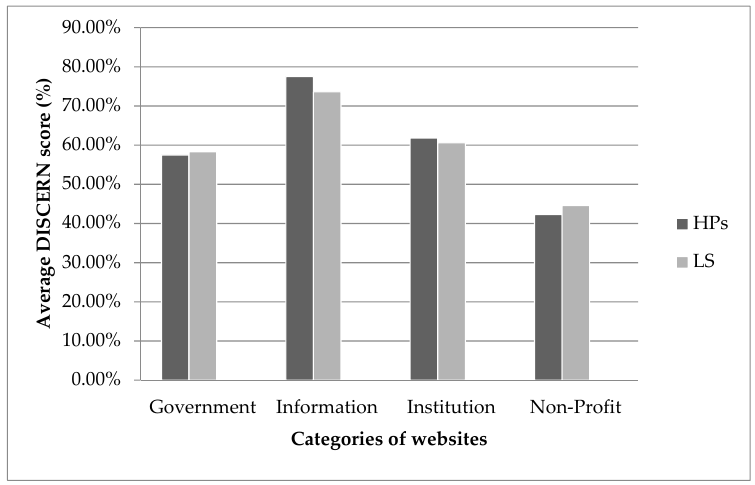
Figure 7. Performance of categories of websites by both Groups.